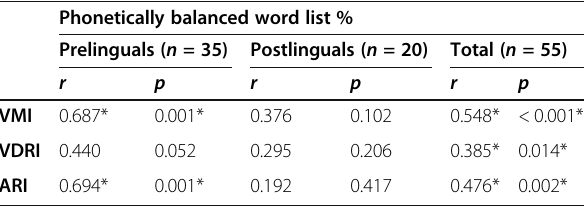
Table 6 Correlation between PBWL scores with different indices of TOMAL – 2 test Phonetically balanced word list %